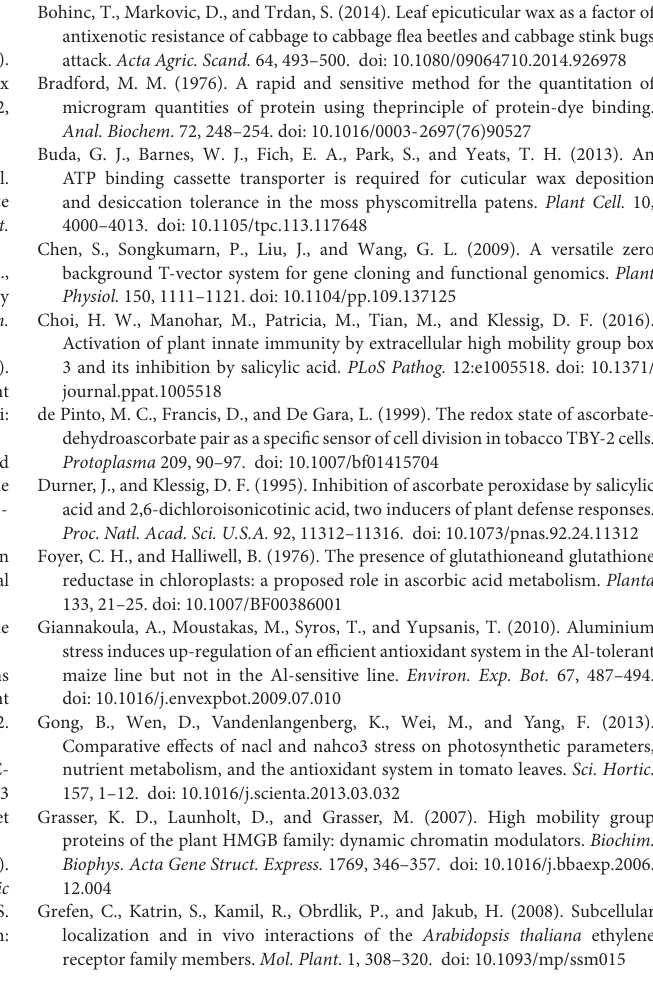
FIGURE S2 | Sequence and phylogenetic analysis of CsHMGB . (A) Analysis of CsHMGB sequence. (B) Phylogenetic analysis of CsHMGB with HMGB proteins in other species; the amino acid sequences of the CsHMGB and HMGB proteins were used to construct phylogenetic trees using a neighbor-joining algorithm. Cp, Cucurbita pelo ; At, Arabidopsis thaliana ; Cs, Cucumis sativus ; Pp, Prunus persica ; Pa, Populus alba ; Cm, Cucumis melo ; Mc, Momordica charantia; Ns, Nicotiana Sylvestris ; Nt, Nicotiana tabacum ; Pt, Populus trichocarpa ; Vv, Vitis vinifera . (C) Conservative HMGB-box structure in various species. FIGURE S3 | CsHMGB levels in the control (Col) and CsHMGB -overexpressing (OX) plants were screened by qPCR. FIGURE S4 | Phylogenetic tree of HMG proteins from cucumber (Cs) and Arabidopsis (At). TABLE S1 | Sequences of the oligo nucleotides used in this